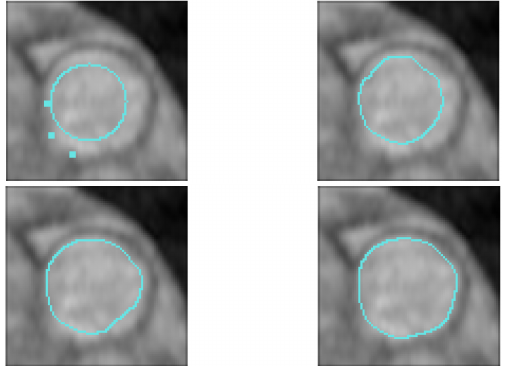
Figure 2. We use Gout et al. [19] algorithm. The initial guess is given inside the region of interest, it is defined by Ψ = ( X − 39 ) 2 + ( Y − 47 ) 2 − 18 2 , the time step is equal to 0.6, space step is equal to 0.1, distance is computed using the fast marching method (Sethian [14]) and the regularization term is equal to 0.8. Top left : Interpolation condition and initial closed contour. Top right : iteration 120. Bottom left : Iteration 240. Bottom right : Iteration 420.